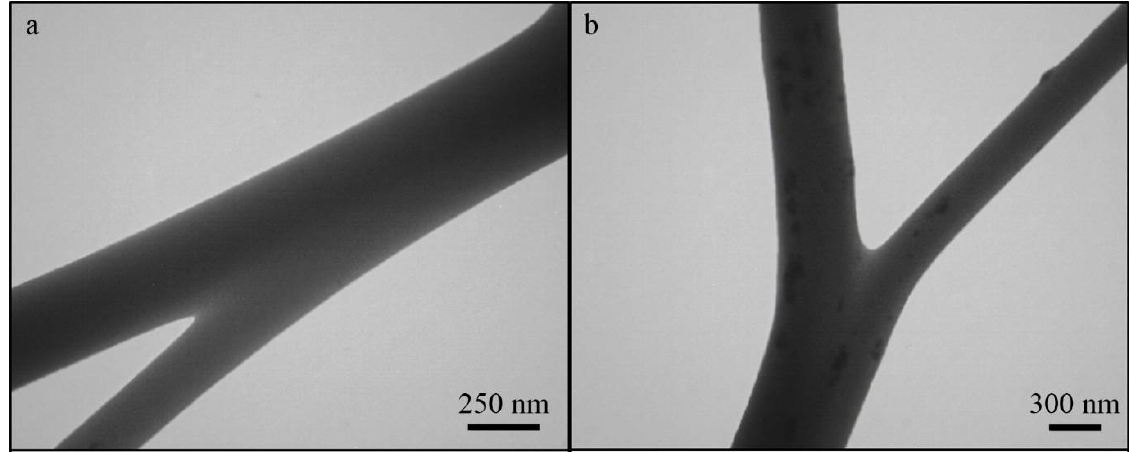
Figure 11. TEM images of PCL ( a ) and 5MNP ( b ) nanofibers.